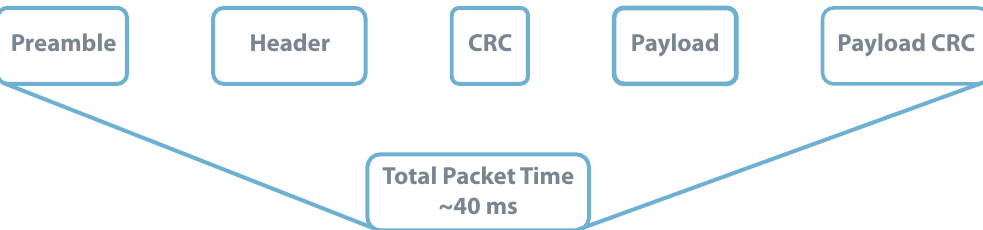
Figure 21. LoRa Packet Structure-SF = 7, BW = 125kHz, CRC = 0 and Payload = 16 bytes. Data from source